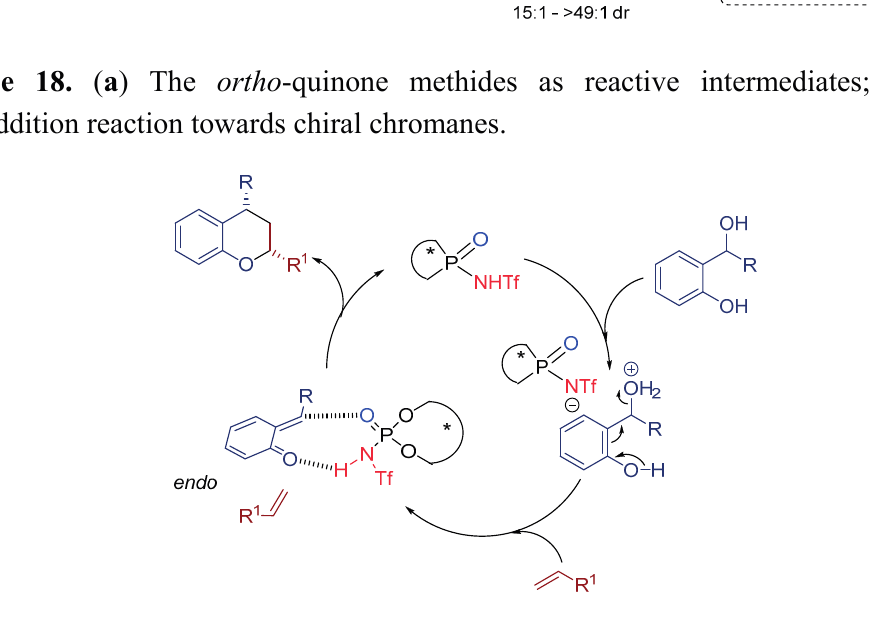
Figure 12. Proposed mechanism for the hetero Diels-Alder reaction, catalyzed by 18